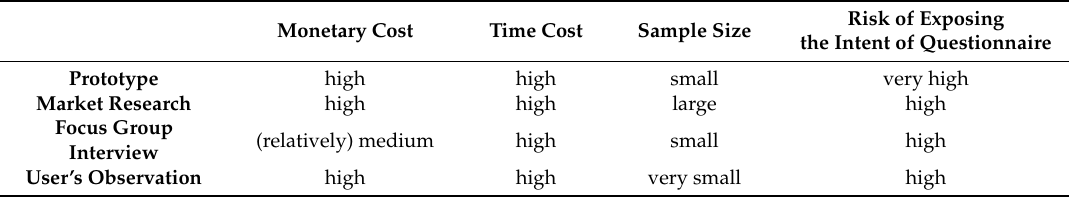
Table 1. Properties of conventional methods for identifying customer needs